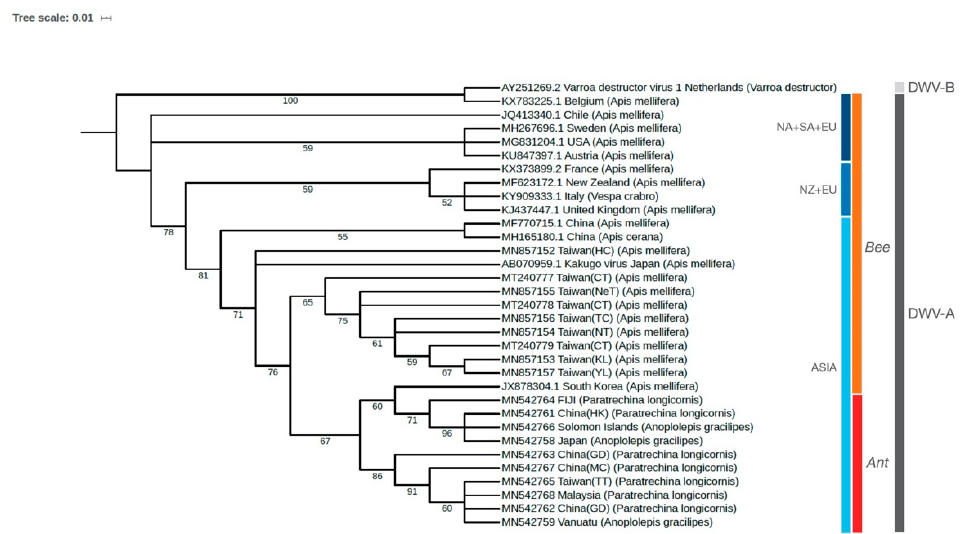
Figure 2. Maximum-likelihood phylogenetic analysis of multiple DWV isolates worldwide, based on the Peptidase C3G gene’s nucleotide sequence. The number at each branch of the phylogenetic tree represents the bootstrap value (5000 replicates). NA: North America; SA: South America; EU: Europe; NZ: New Zealand.